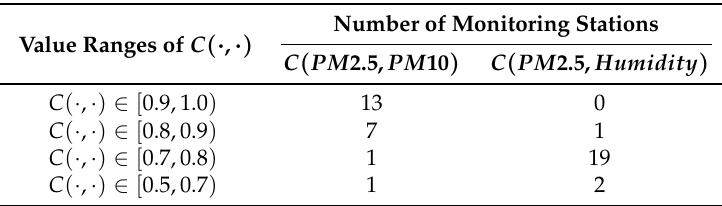
Table 2. Statistical result of correlation analysis.